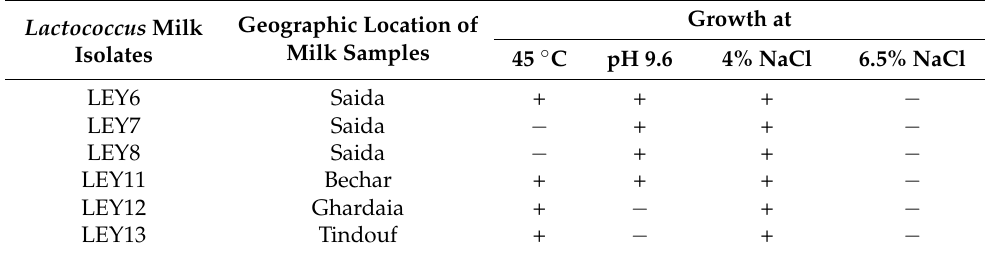
Tindouf − − − Negative; + Positive.